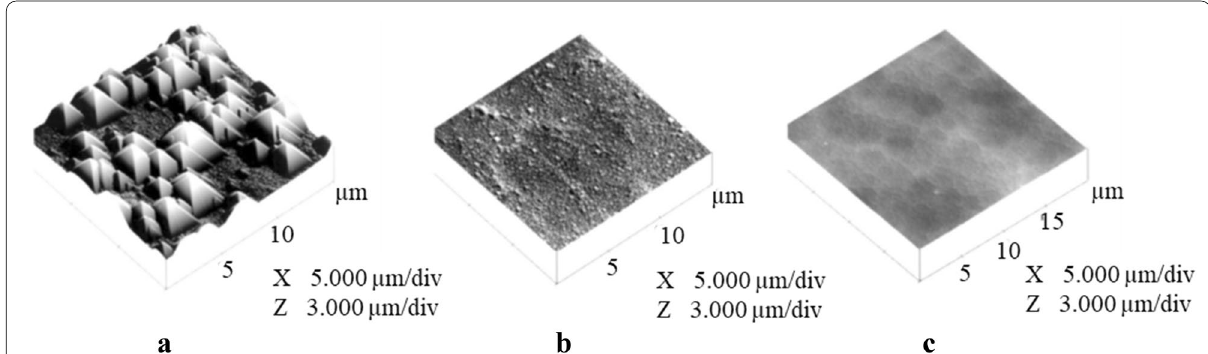
Fig. 8 AFM images of Si{100} surface etched in 2 M KOH solution at 60 ℃ for 60 min under three different conditions: a solution saturated with Ar gas, b ultrasonic agitation applied to the solution ( a ), c solution saturated with O 2 gas [80], © 1997 IOP